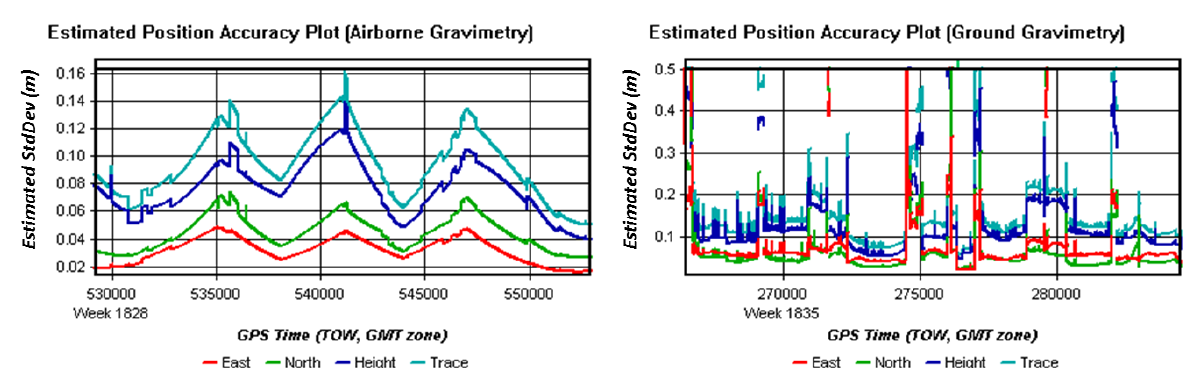
Figure 7. Velocity profile plots of airborne and ground test.